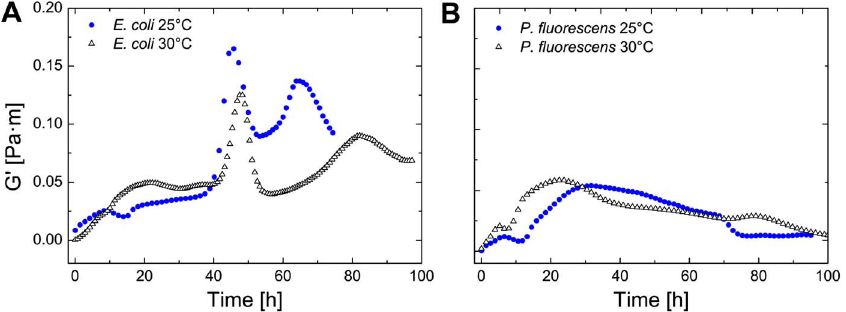
Figure 5. Effect of temperature on biofilm formation of E.coli and P.fluorescens . The elastic (G0) and viscous (G00) is plotted against the time of E. coli (A) and P. fluorescens (B) with changing temperature from 25 u –30 u